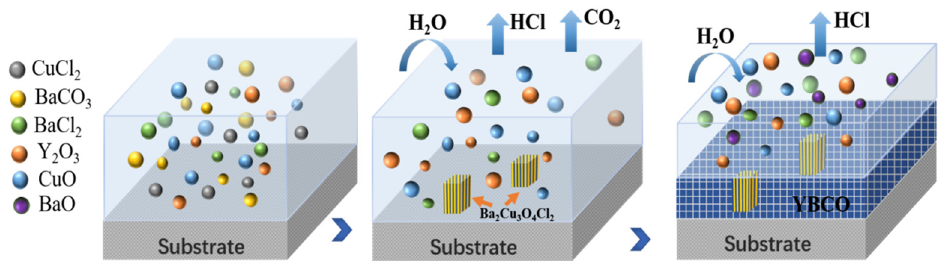
Figure 10. Growth mechanism of Cl-added YBCO grains.